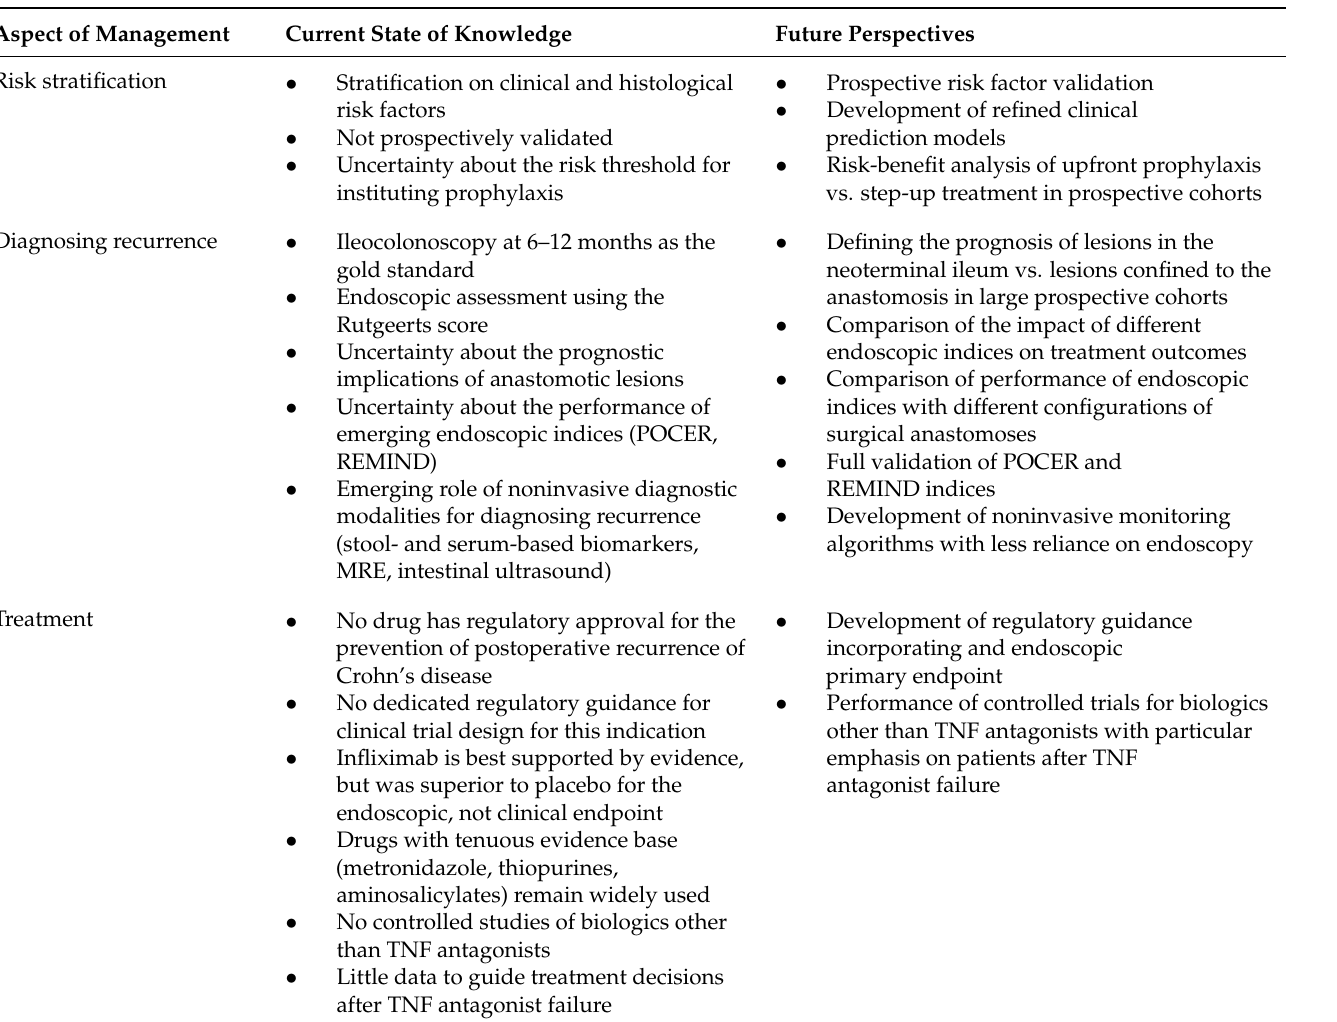
Table 3. Current state of knowledge and future perspectives in the management of postop- erative Crohn’s disease. Abbreviation: MRE—magnetic resonance enterography; TNF—tumor necrosis